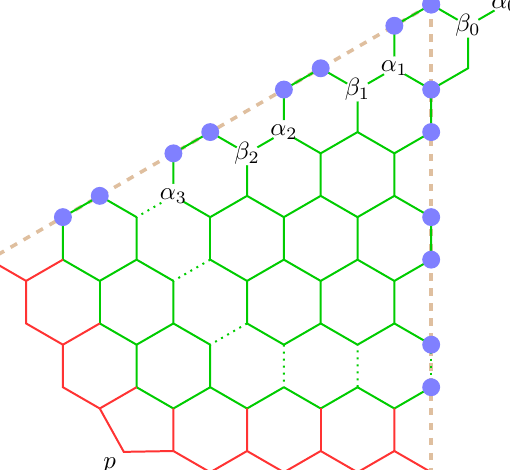
Figure 5: Fundamental region appropriate to an A eigenvector of a ( H ( k + 2 , k, k, k )) with even k , shown explicitly for 2 k = 6 . Blue filled circles indicate zero entries in the vector that are forced by symmetry. Green edges are present in both parent and altan; red edges are added in the altan. Mirror lines are shown in brown. Notation for variables { α { β i } is discussed in the text. Vertex p in the altan breaks the bipartite nature of this region, and allows determination of relationships between { α and { β in the A kernel i } i } 2